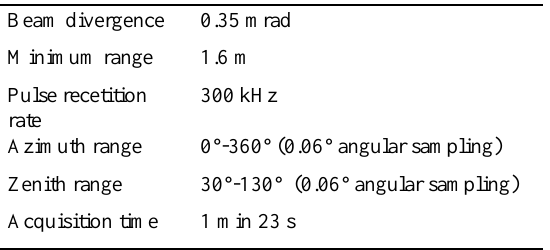
Table 1. Riegl VZ-400 scanner settings for data acquisition